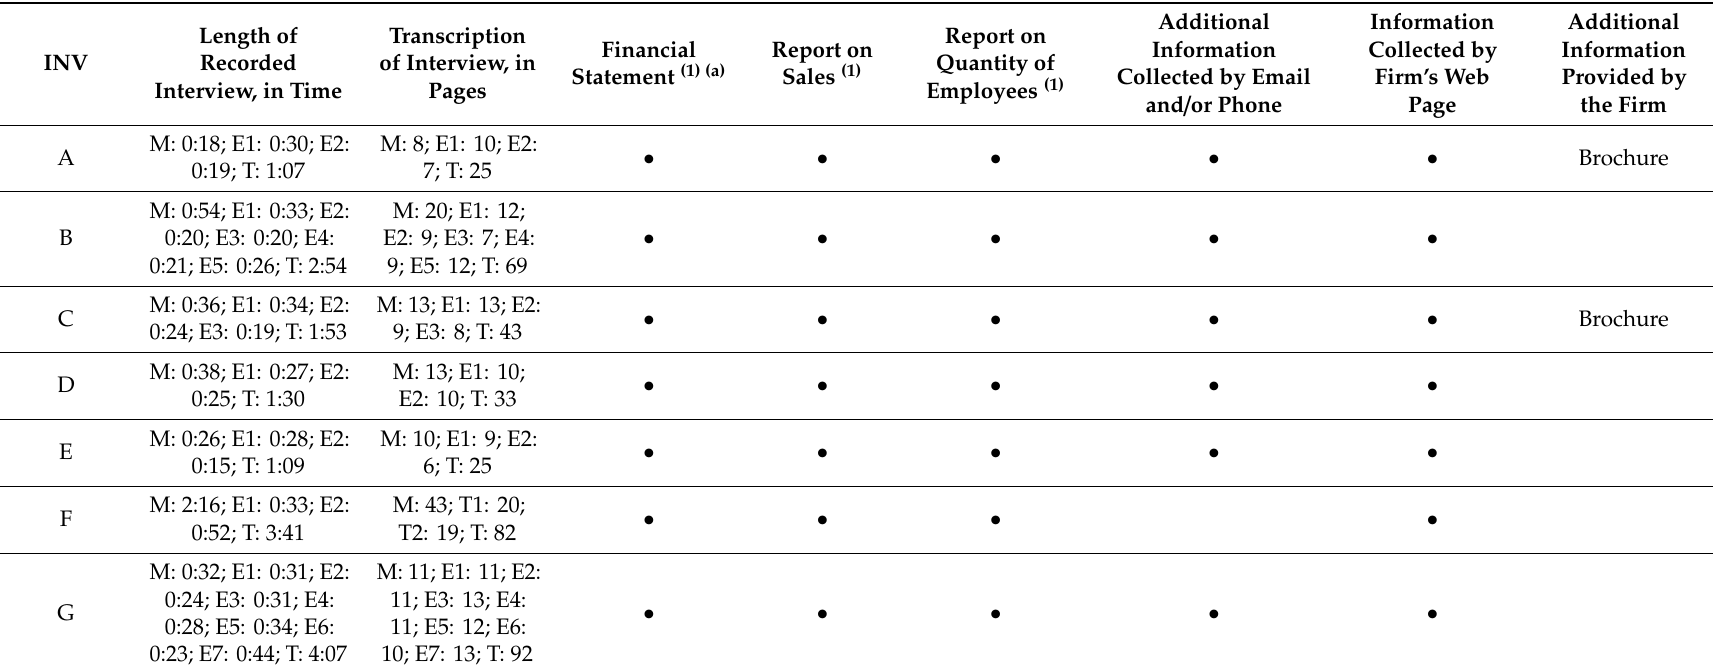
Table 3. Information collected from each INV, in